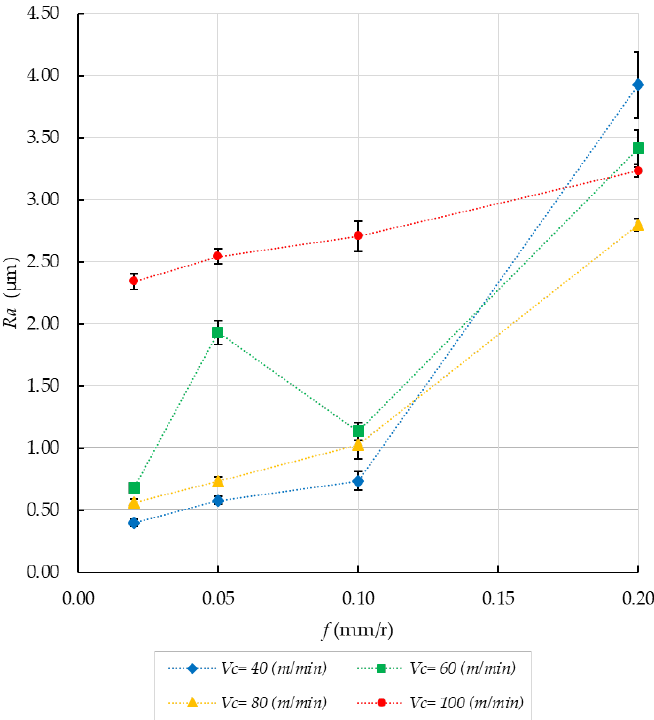
Figure 6. Evolution of Ra / f for all the cutting speeds studied. Error bars show the statistical standard deviation.